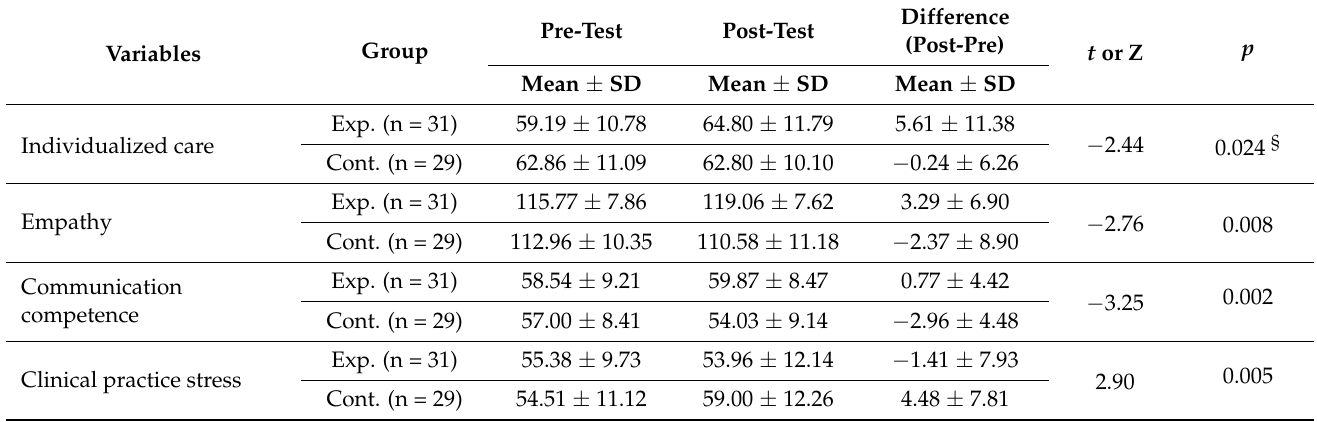
Table 4. Comparison of dependent variables between the two groups after intervention (n =